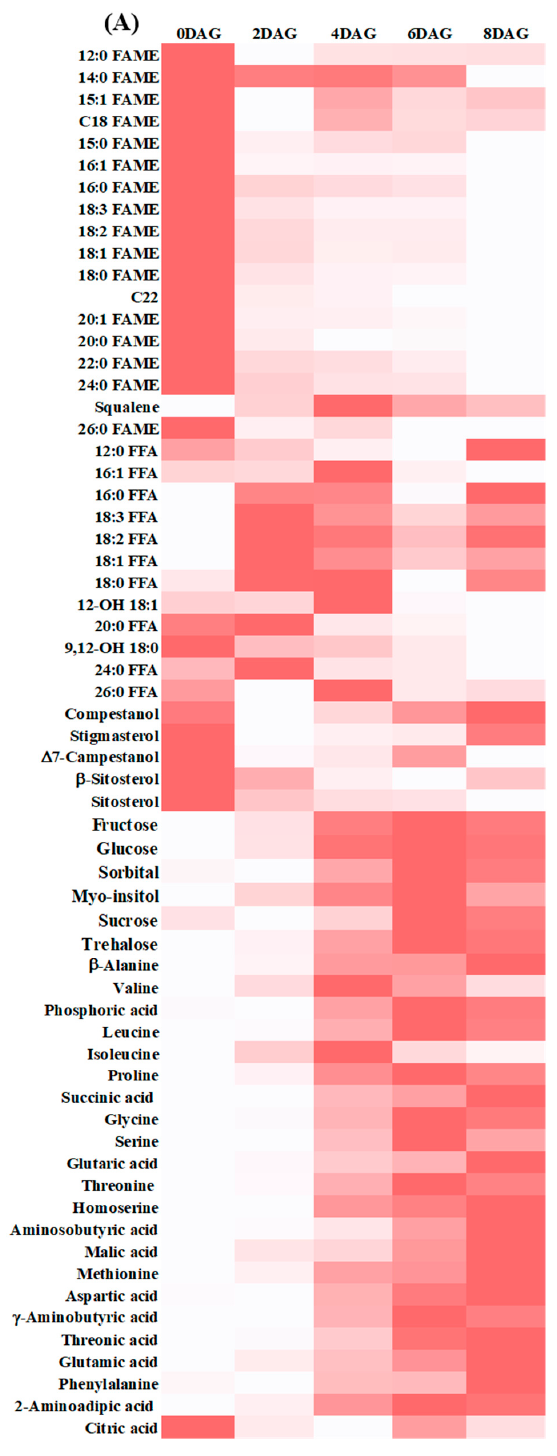
Figure 4. Heat plots of metabolites ( A ) and flavor compounds ( B ) in sacha inchi seeds at different germination times. FAME, fatty acid methyl ester; FFA, free fatty acid; DAG, days after germination.